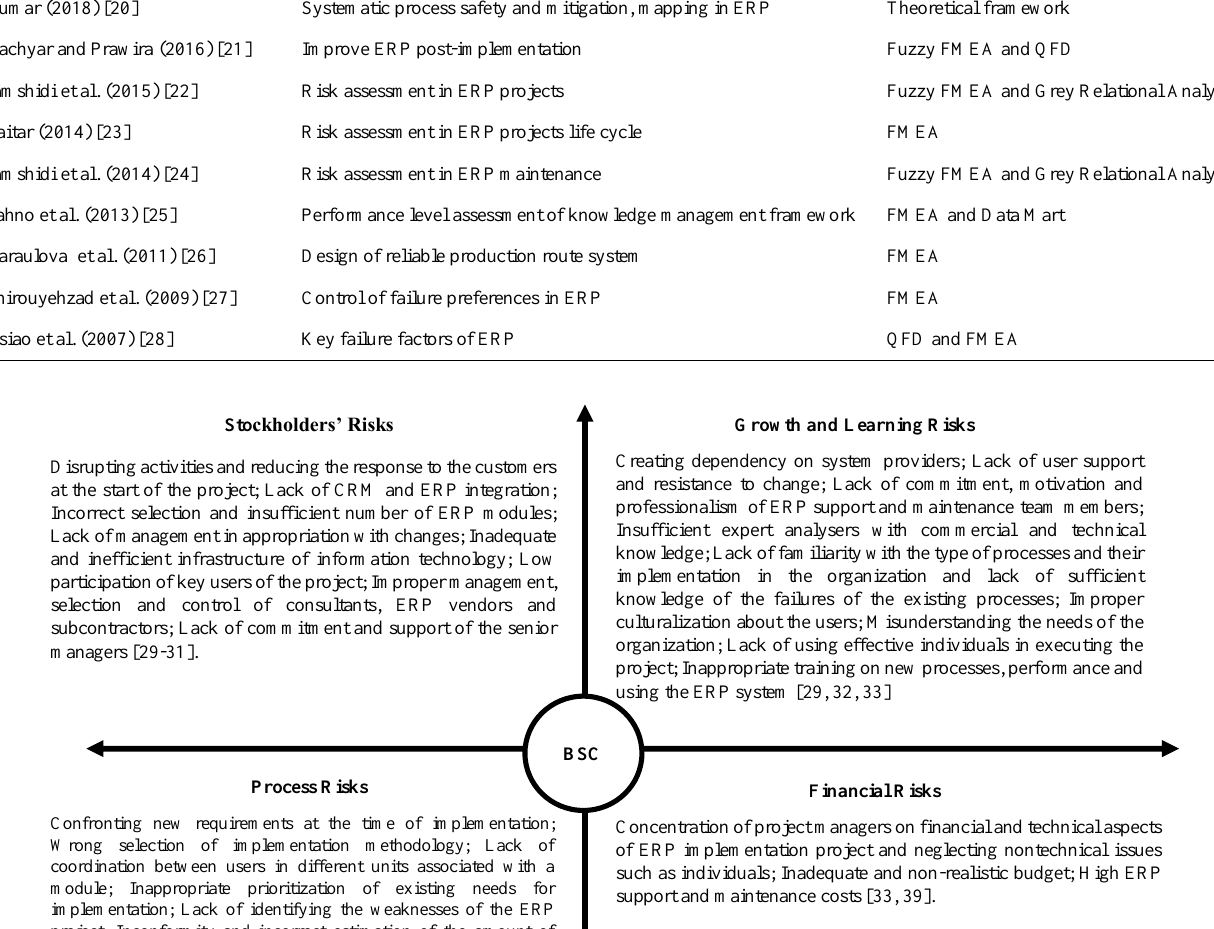
Figure 1. ERP project failure factors based on BSC